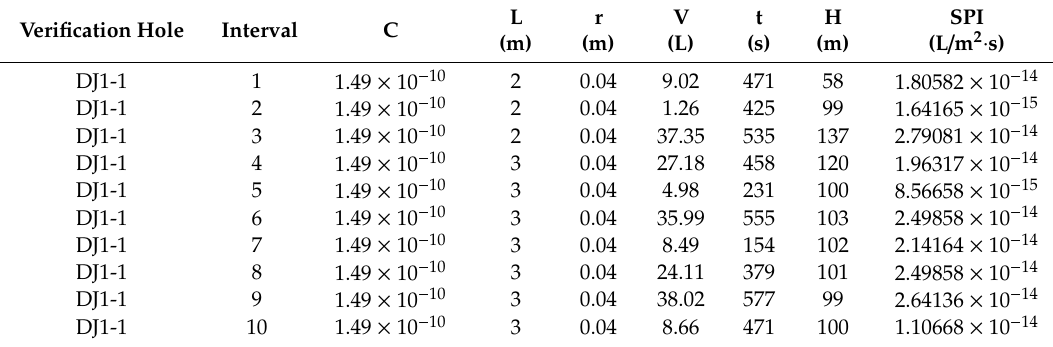
Table 2. Sample of the data set of the secondary permeability